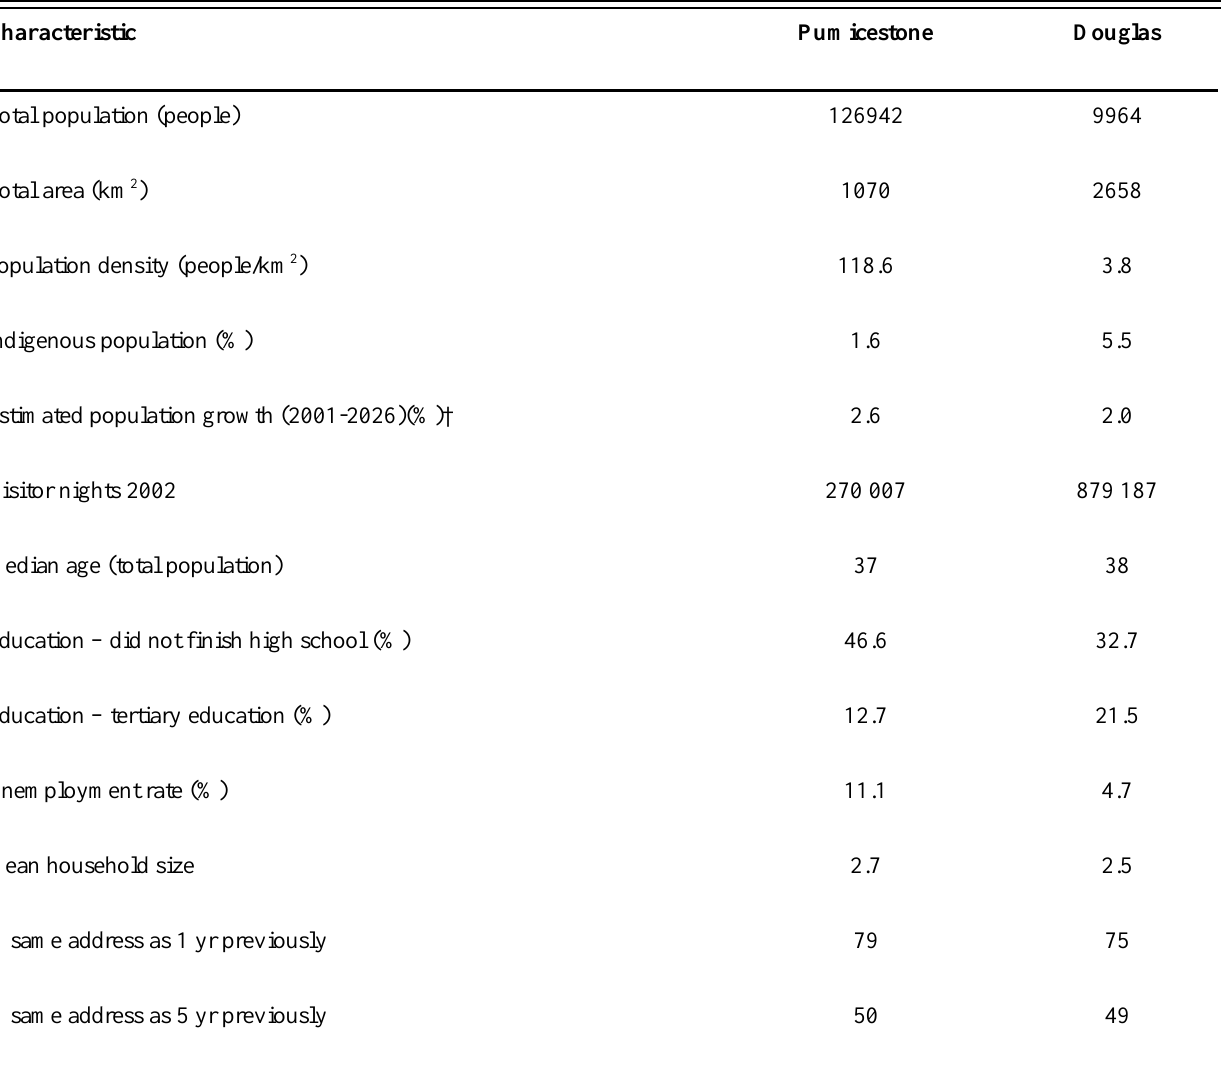
Table 1. Social and economic characteristics of the study